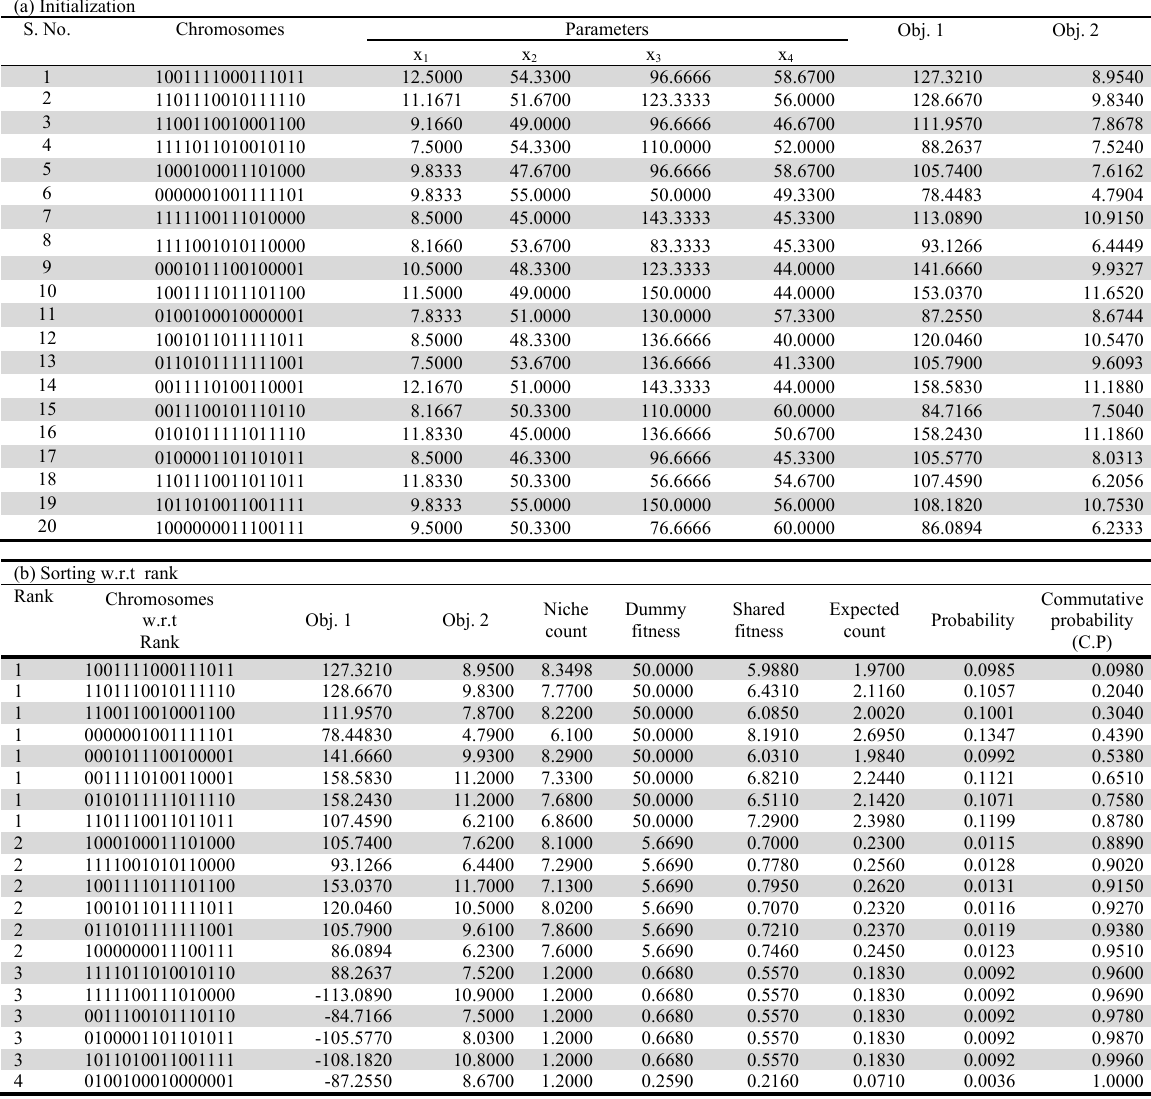
Results of NSGA-II demonstration for